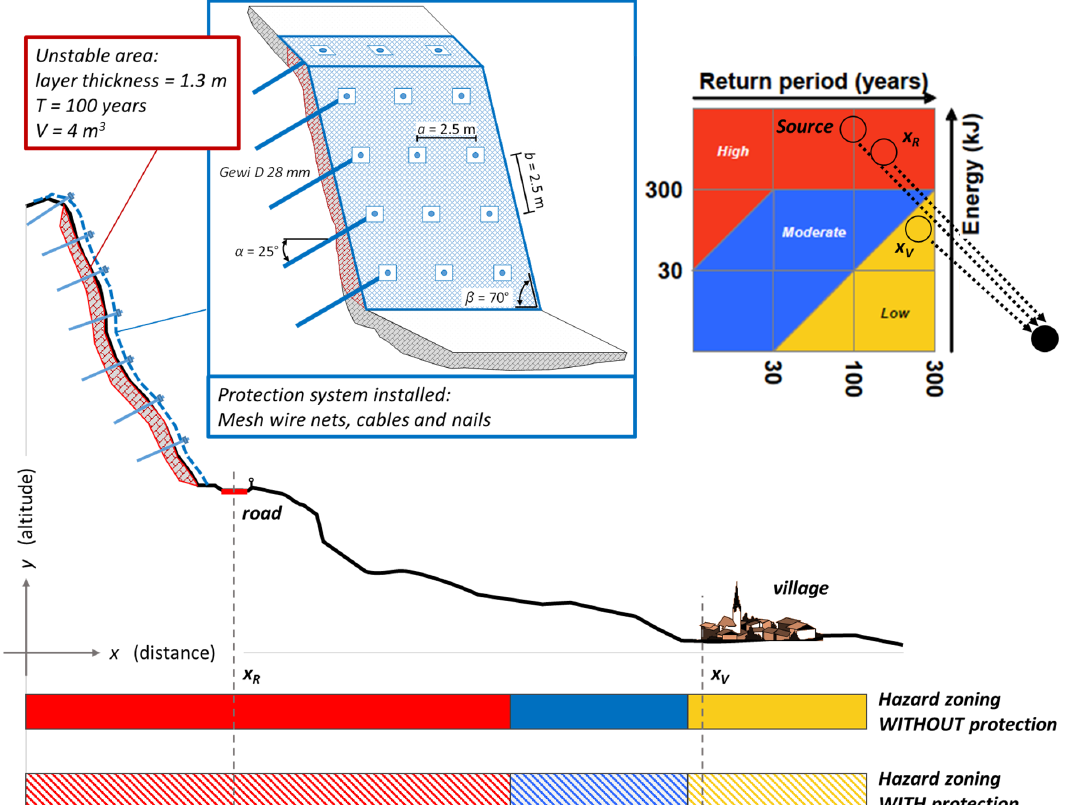
Figure 3. Example 1: hazard zoning obtained along the slope without and with the effects of a protection system installed at the rock fall source area. The mitigation effects all over the slope are illustrated with reference to the Swiss rock fall intensity–frequency